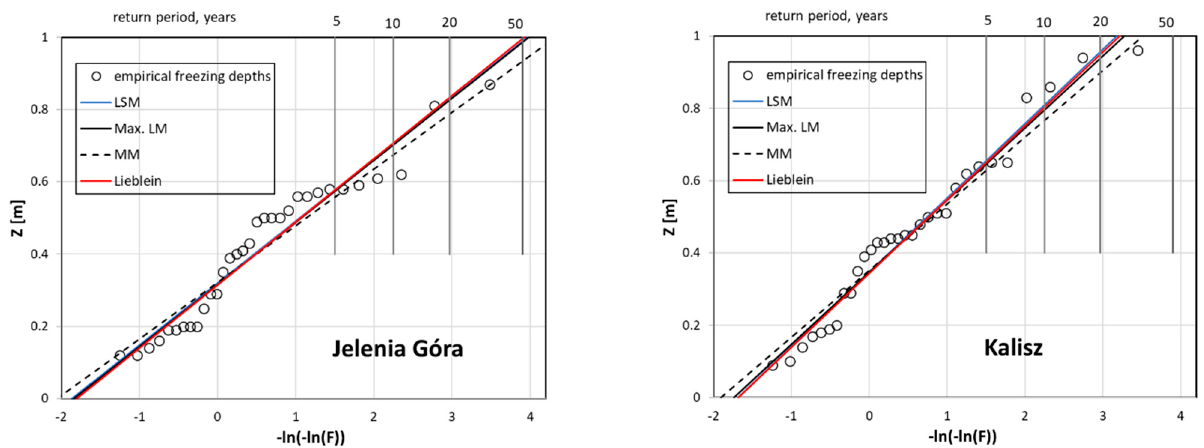
Figure 4. Estimation models for results from Jelenia Góra ( left ) and Kalisz ( right ) station—predicted position of zero isotherm for return period.